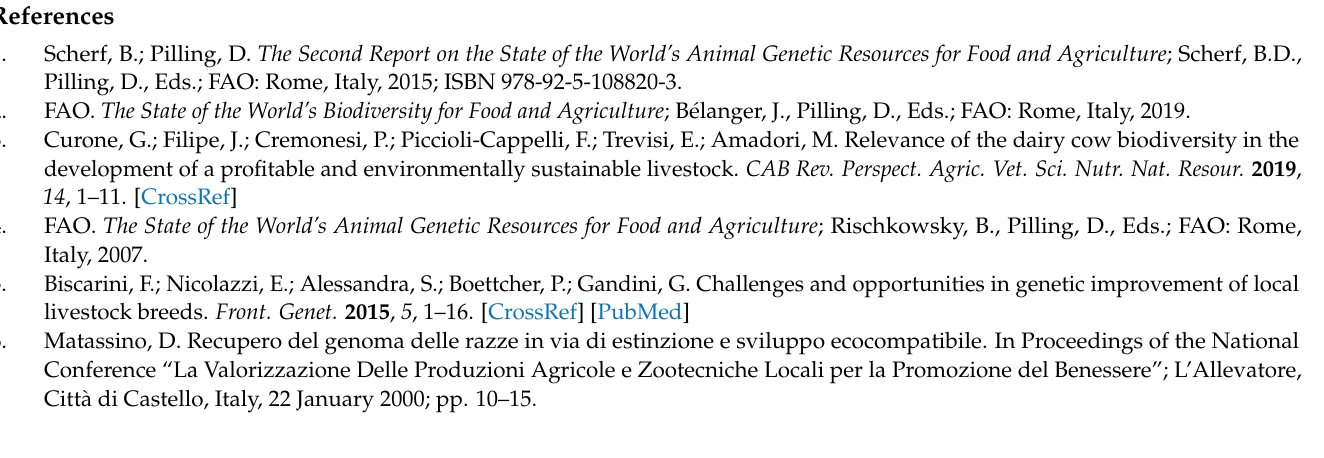
BAS = basophil percentage; Table S1: Significance of the Kolmogorov–Smirnov tests and numbers of outliers eliminated for each